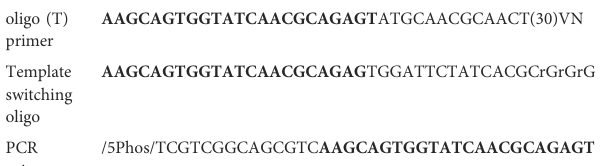
TABLE 2 Total yield of PCR ampli fi ed cDNA. Total RNA from four samples was processed either following Oxford